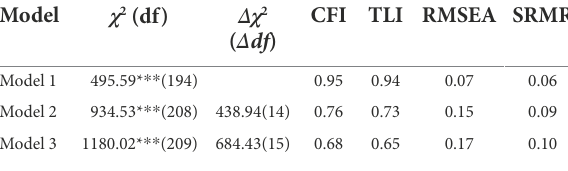
TABLE 1 Results of confirmatory factor